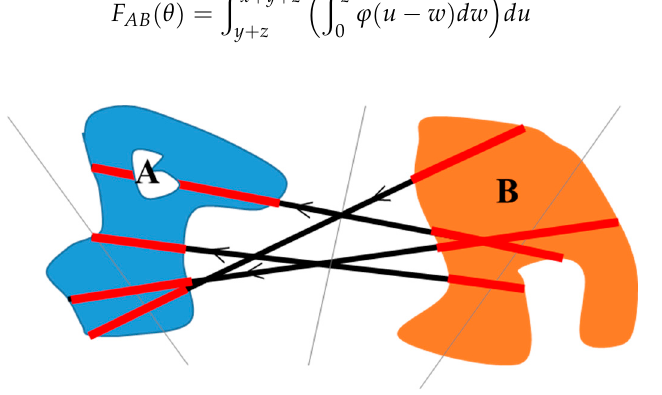
Figure 1. Expression of the histogram of force. The arrow means that position A is relative to position B , and the red line represents the secant line of the object.